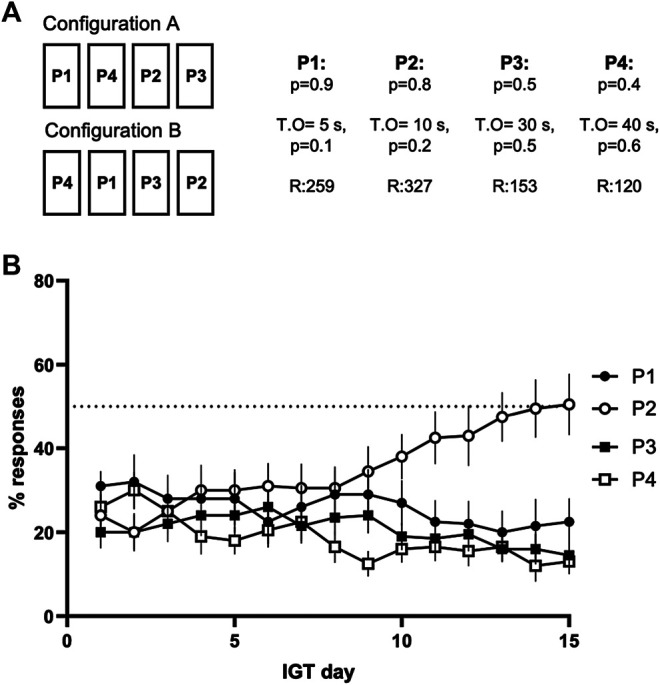

(A) The four active panels had unique reward-punishment contingencies, and the two different configurations, A and B, were used in different chambers. The panels are named after the number of sucrose rewards each of the panels gave. The first p-number indicates the probability of the reward. The punishments were given as time-out periods, the probability and the length of the time-out rising together with the reward (T.O for the time-out in seconds, p for the probability of the punishment). The R-numbers indicate the maximum number of reinforcements of each panel if it was chosen exclusively during the session (B) The development of option selection during the first 15 days of the Iowa Gambling Task phase, prior to the drug treatment sessions. Data shown as mean ± SEM.